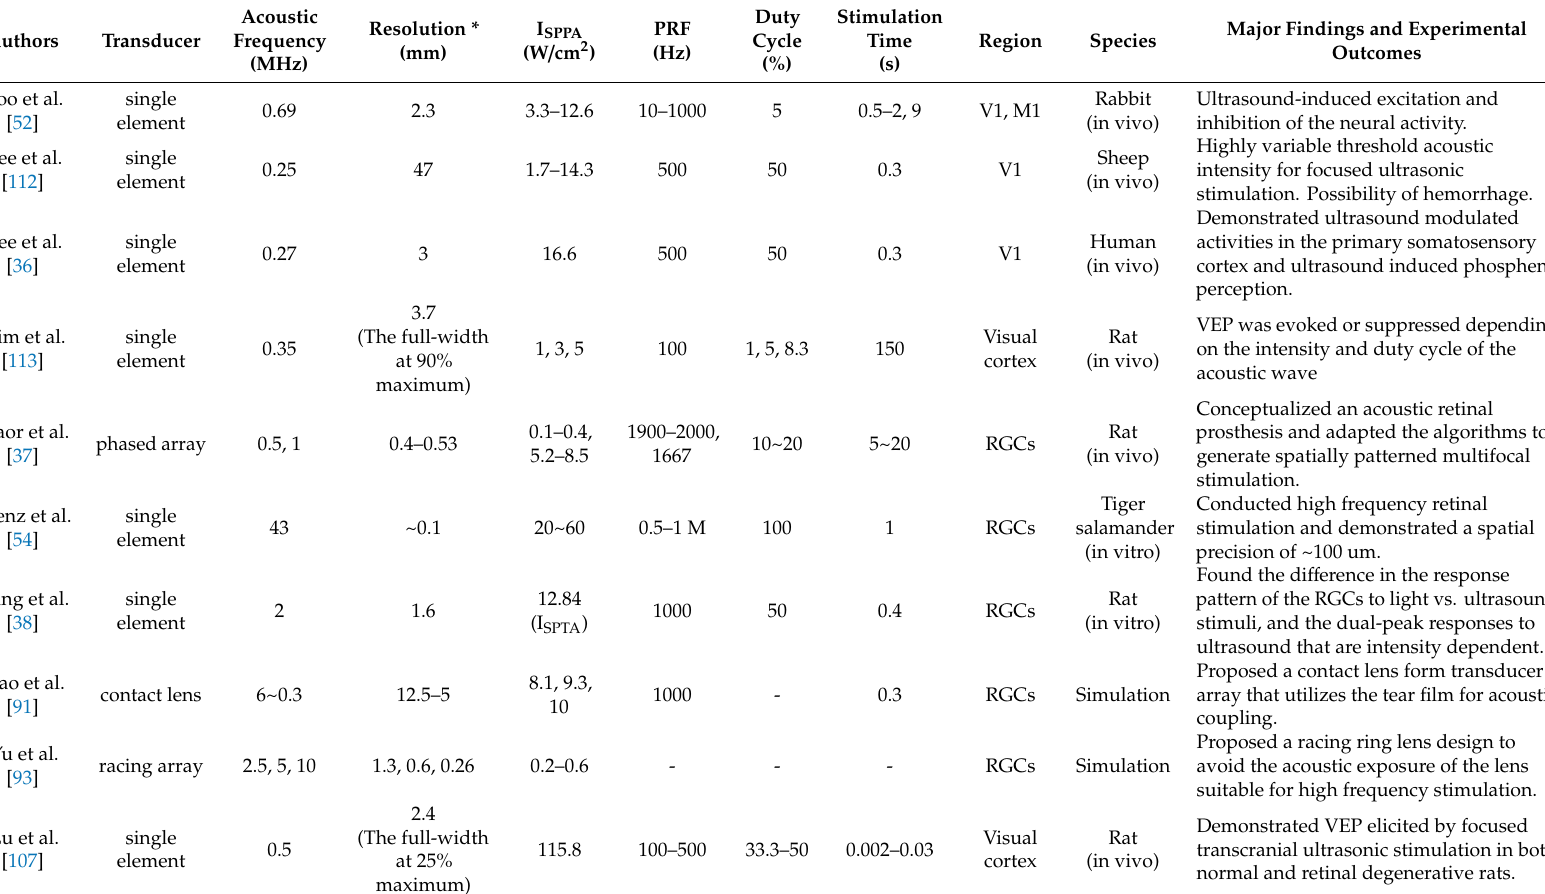
Table 2. Summary of the representative literatures on ultrasonic retinal and visual cortical stimulation. (Information compiled from a literature search for published studies as of June 2020 on retinal neuromodulation and transcranial visual cortical stimulation by